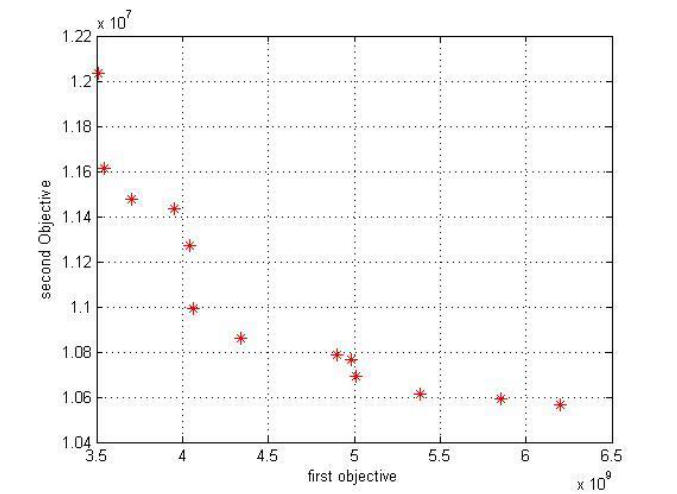
Fig 9 . Pareto solutions obtained for problem